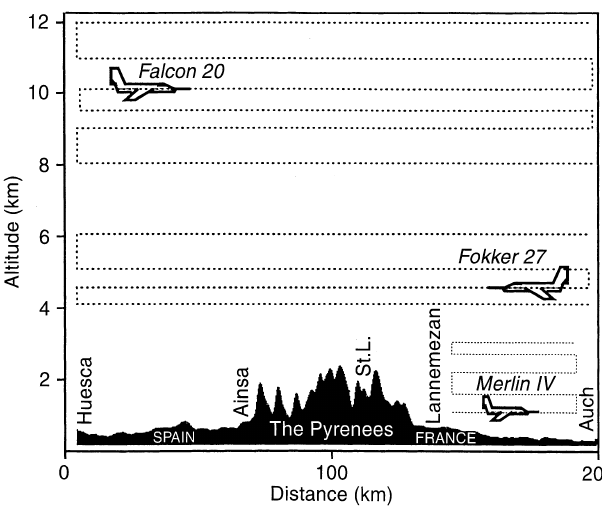
Fig. 2. Flight plan of the aircraft for a mountain wave event during the PYREX experiment. The 6 upper runs (altitude between 8 and 12 km) were performed by the Falcon 20 , the 4 runs between 4 and 6 km of altitude were performed by the Fokker 27 . On the downwind side of the mountain, the Merlin IV ran several legs perpendicular and parallel to the Pyrenees main axis over France for a southerly flow and over Spain for a northerly flow. The shaded area represents the mountain relief measured by the Fokker 27 during its lowest altitude run